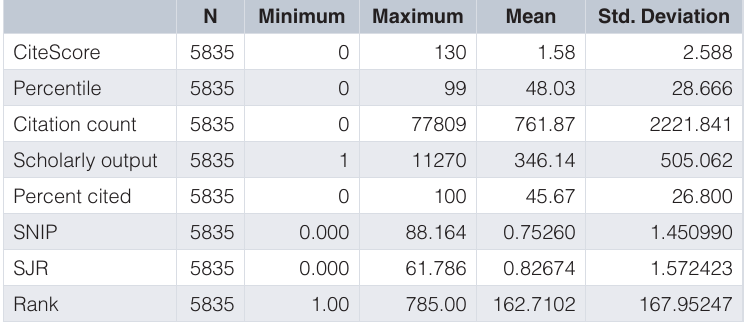
Table 1. Descriptive statistics for medical